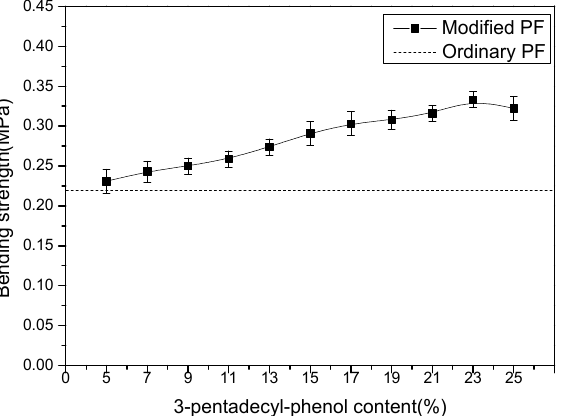
Figure 5. The effect of 3-pentadecyl-phenol with different contents on the bending strength of the foam.